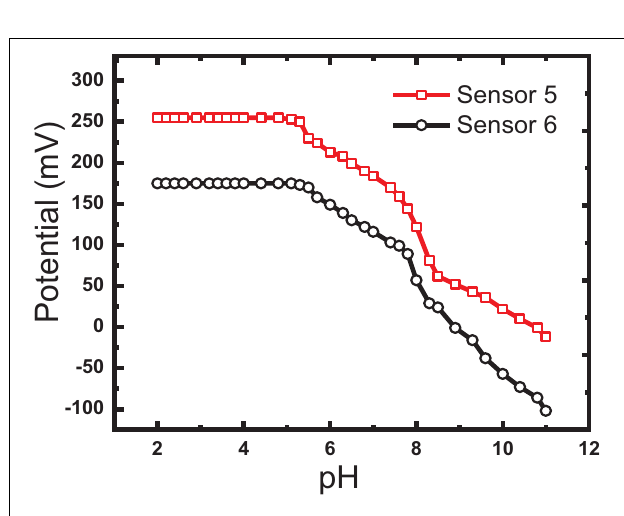
FIGURE 9 | Effect of pH on the measured potential of sensors 5 and 6.